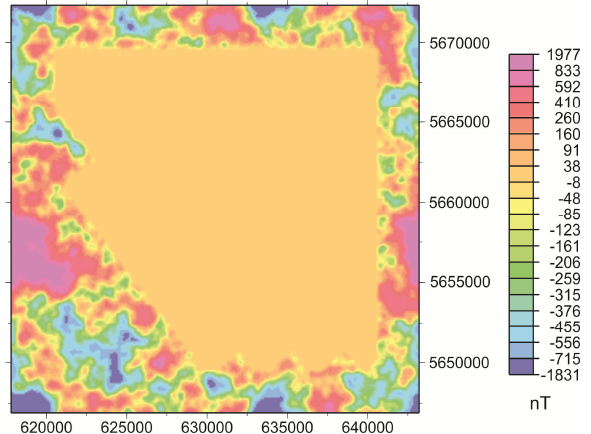
Fig. 5. Conditioned field given by the field in Fig. 4 subtracted from the field in Fig. 3. This conditioned grid is zero at the observed field grid edges (blue line, Fig. 1) and within the survey area. Coordinates in metres are UTM zone 21.